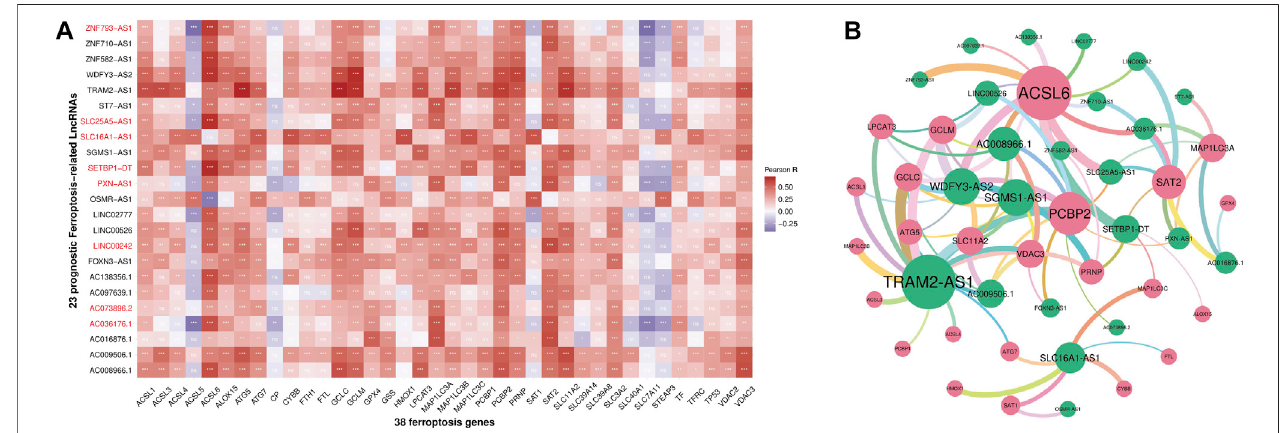
FIGURE2| Heatmap (A) andcorrelationnetwork (B) between38ferroptosis-relatedgenesand23prognosticferroptosis-relatedlncRNAs(ns: p ≥ 0.05,* p < 0.05, ** p < 0.01, *** p < 0.001).